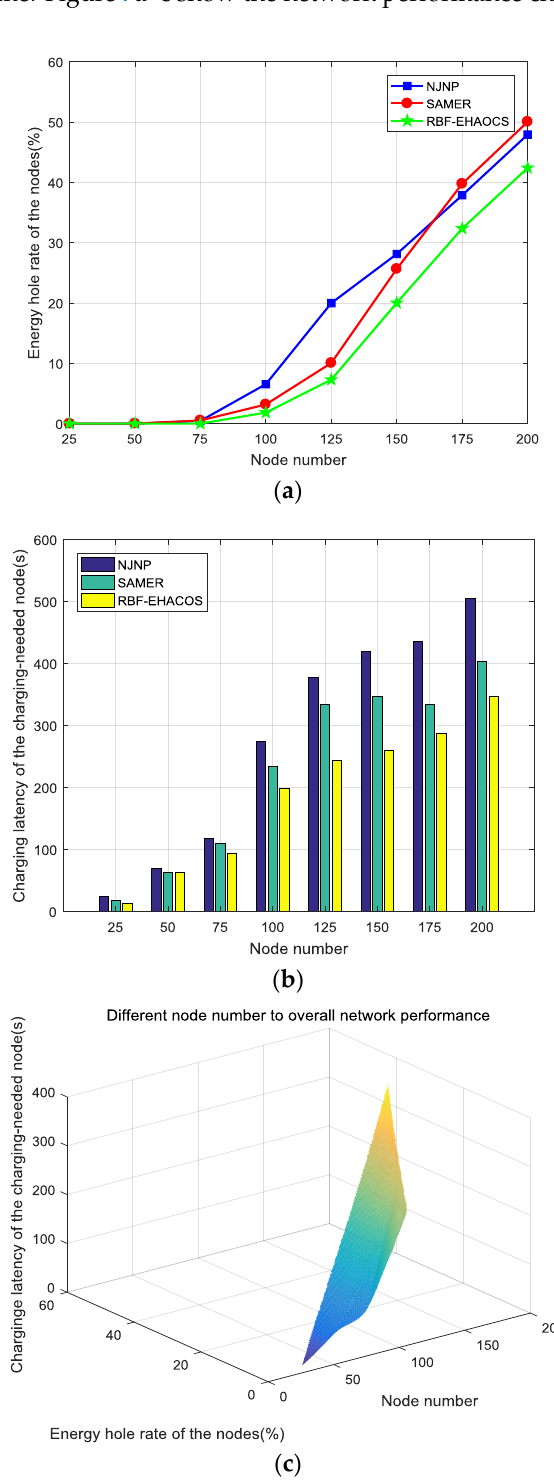
Figure 7. ( a ) Energy hole rate of the nodes, ( b ) charging latency of the charging-needed nodes, and ( c ) overall network